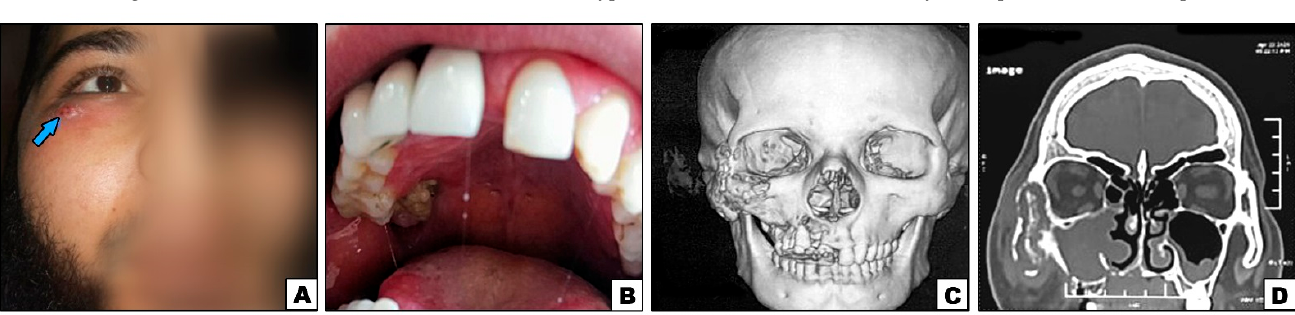
Figure 1. Case#2: ( A ) Extraoral swelling of the right side of the face (note: sinus tract inferolaterally to the eye {arrow}). ( B ) Exposed necrotic bone in the right posterior palate. ( C , D ) 3D and cronal CT showing bone destruction of right maxilla, inferior orbital rim, and lower part of zygoma.